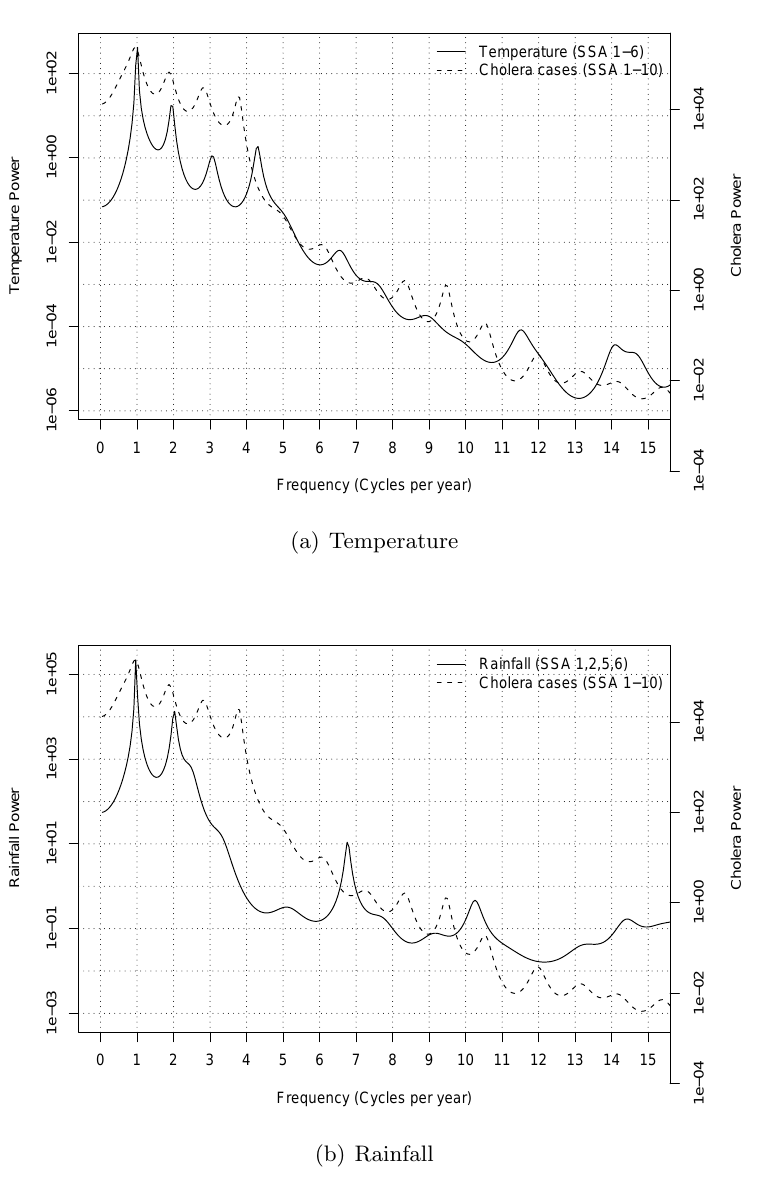
Figure 5: Comparison of power spectra of cholera cases, and two environmental inputs, obtained using the Maximum Entropy Method (MEM). Note that the cholera spectrum power is plotted on its own scale, so absolute power is not comparable in these